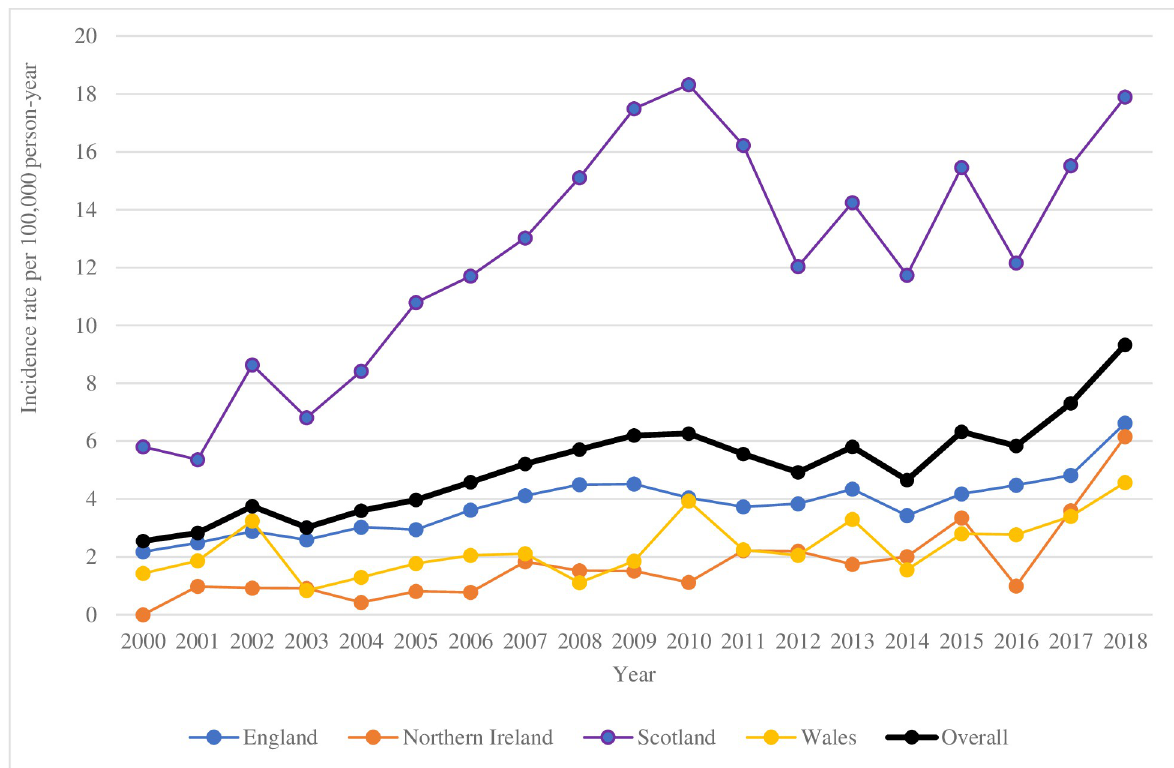
Fig 1. Evolution of Lyme disease incidence rate over study period per